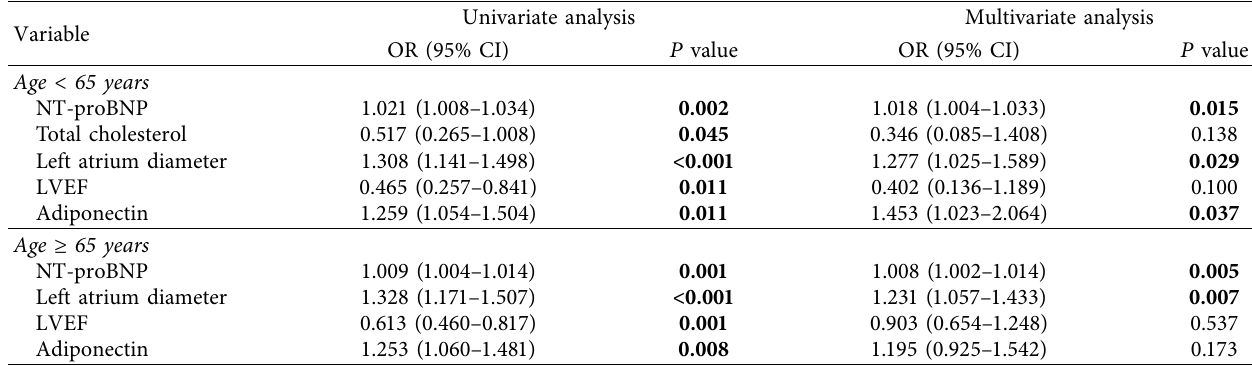
Table 5: Univariate and multivariate logistic regression analysis for the independent predictors of AF stratified by